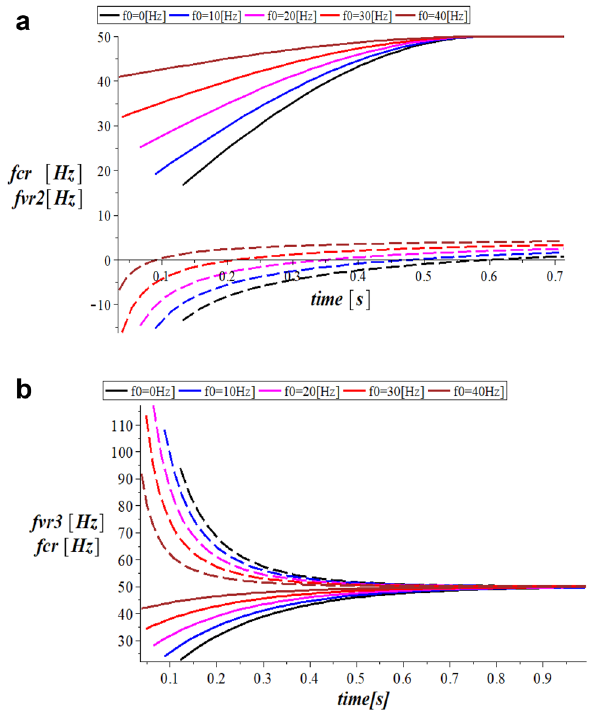
Fig. 21 Illustration of the inverse problem solution: required current frequency functions f cr (as output – solid lines), and voltage frequency functions f vr (as input–dash lines) – for f 50 (Hz). The case presented in 0,10,20,30,40 (Hz) and f k = 0 = Fig. 21. a concerns sinusoidal frequency increase ( T = 0.6(s) ), and in Fig. 21. b concerns exponential frequency increase ( T = 0.075(s)